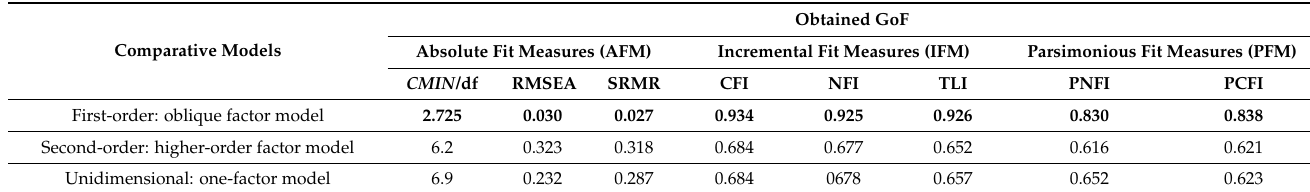
Table 6. Comparison of three alternative